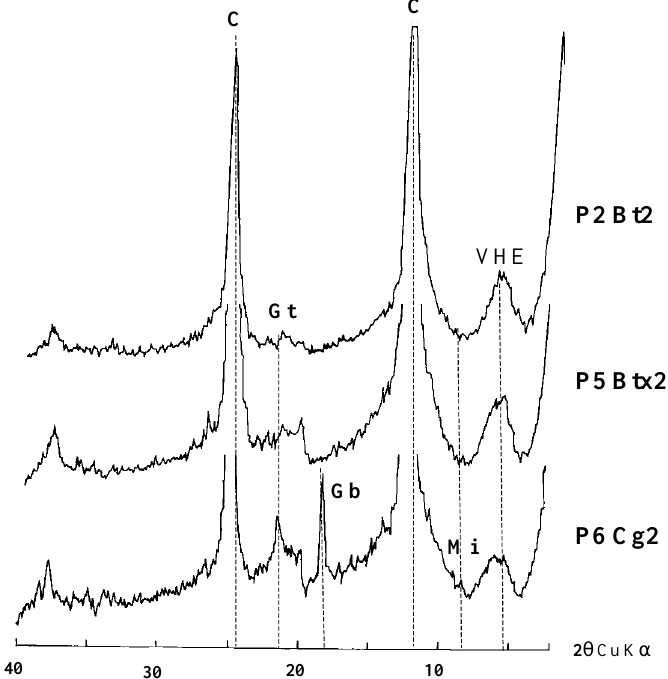
Figura 2. Difratogramas de raios-X da fração argila (K + 25°C) dos horizontes diagnósticos dos perfis P2 (Bt2), P5 (Btx2) e P6 (Cg2). VHE = Vermiculita hidróxi-interestratificada; Mi = Mica/ilita; C = Caulinita; Gb = Gibbsita; Gt =